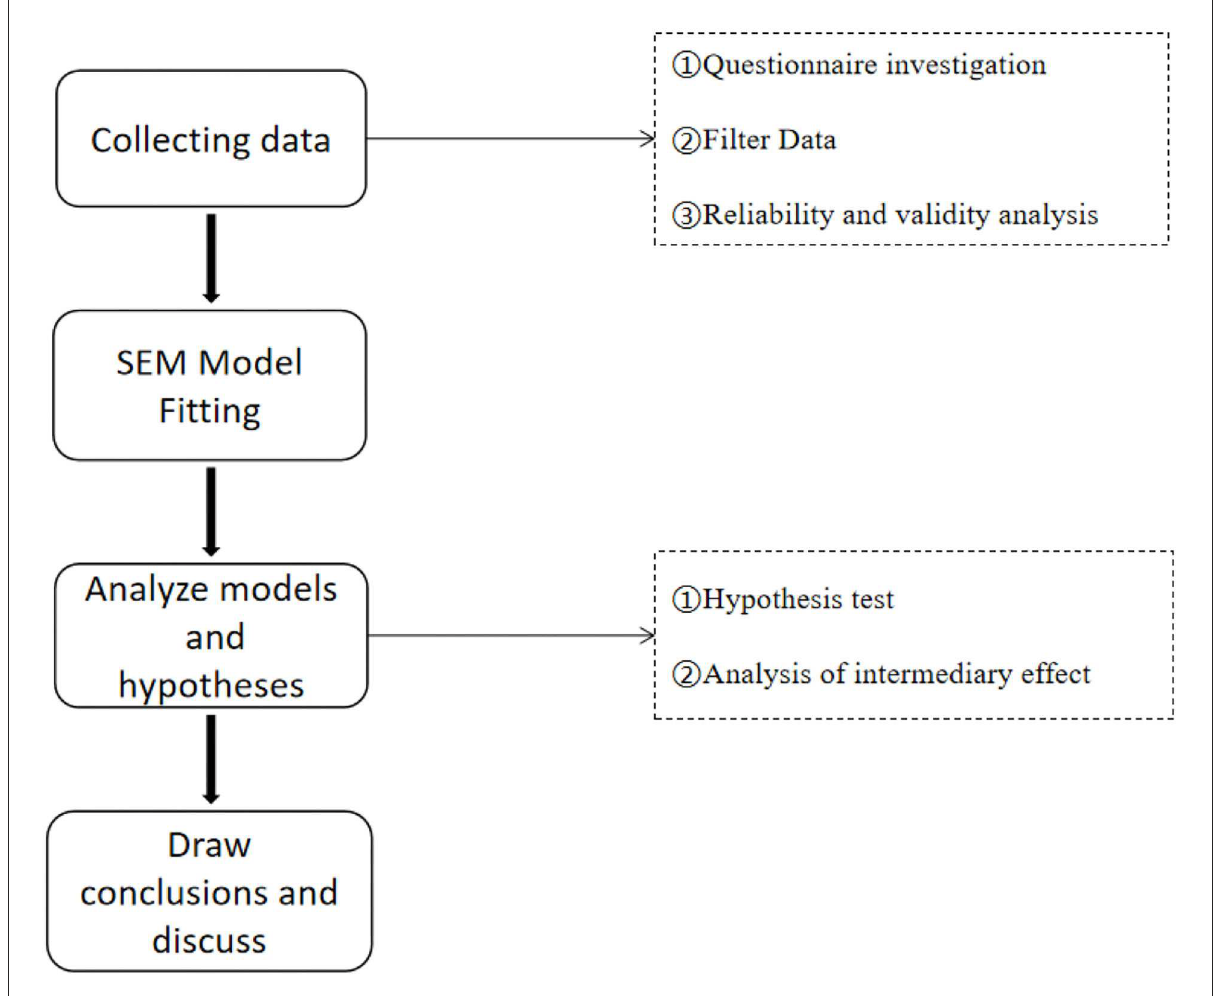
FIGURE3 Research flow